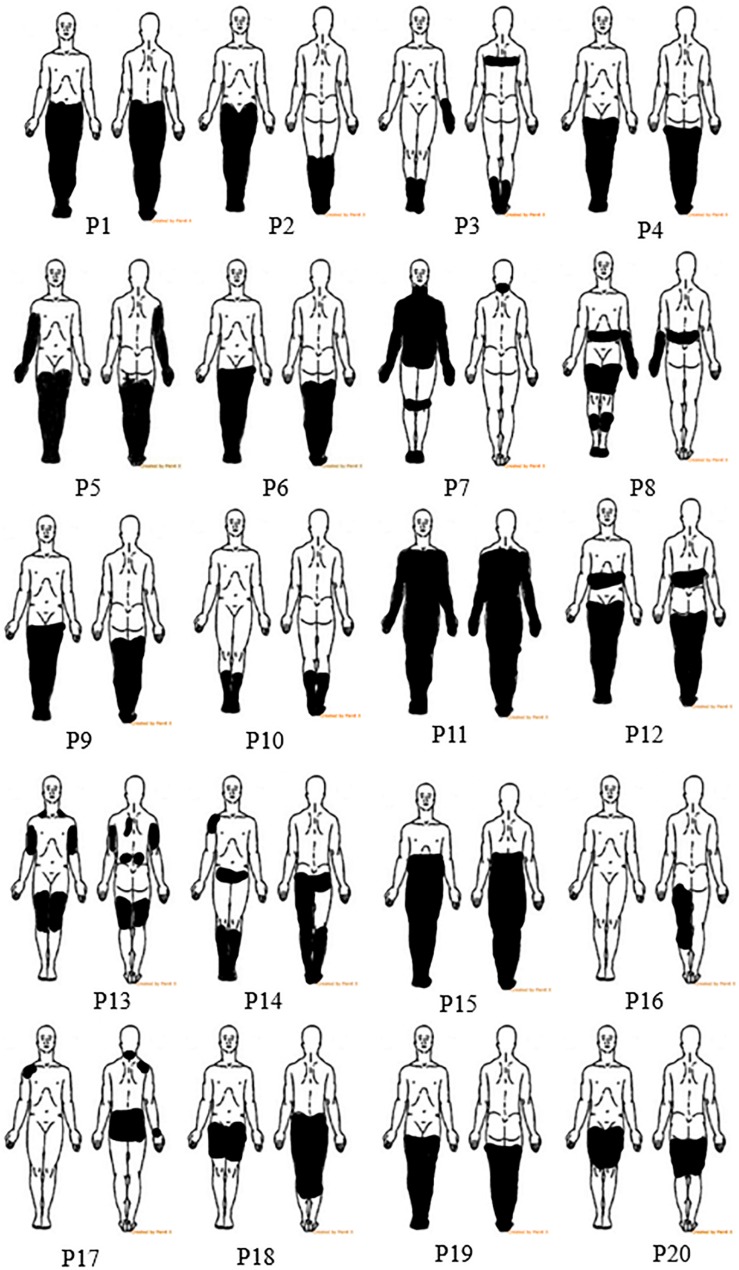
Body charts showing pain location for all 20 participants.